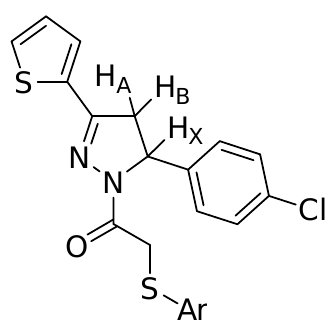
Figure 1. ABX system of the pyrazoline